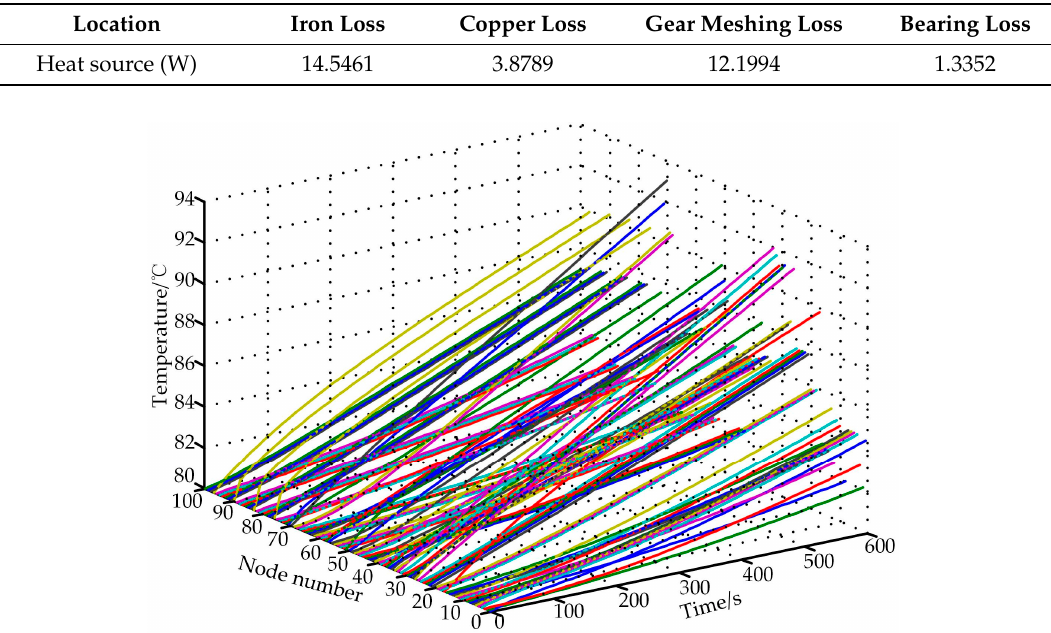
Table 3. Power loss of the motor and reducer.